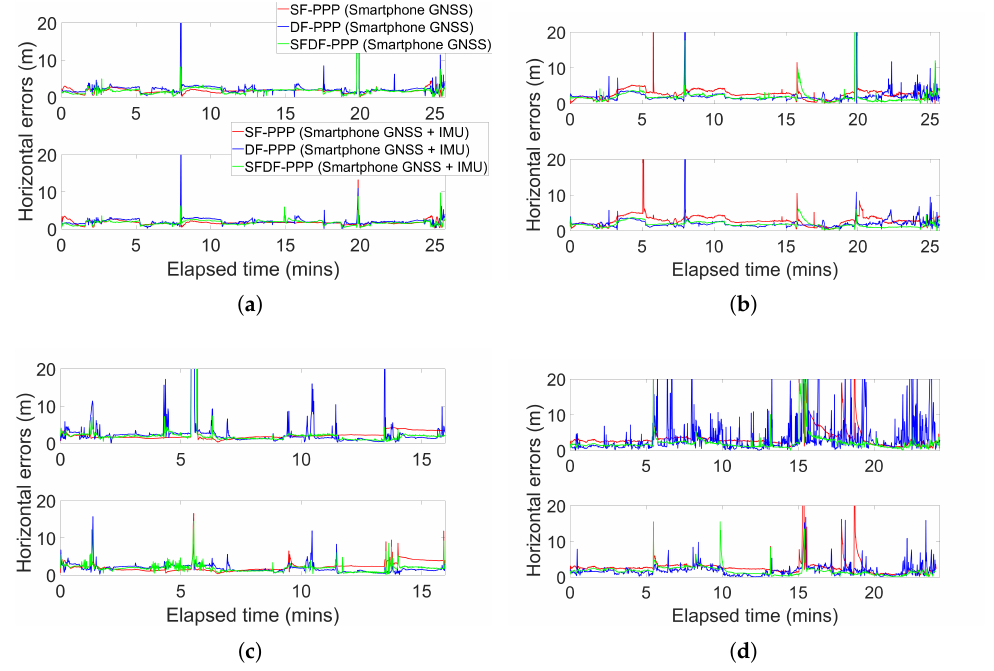
Figure 11. Horizontal error with respect to the reference trajectory comparison for different datasets processed by single-frequency, dual-frequency, single- and dual-frequency PPP and PPP/IMU strate- gies. ( a ) Horizontal position error for dataset M1. ( b ) Horizontal position error for dataset S1. ( c ) Horizontal position error for dataset M2. ( d ) Horizontal position error for dataset